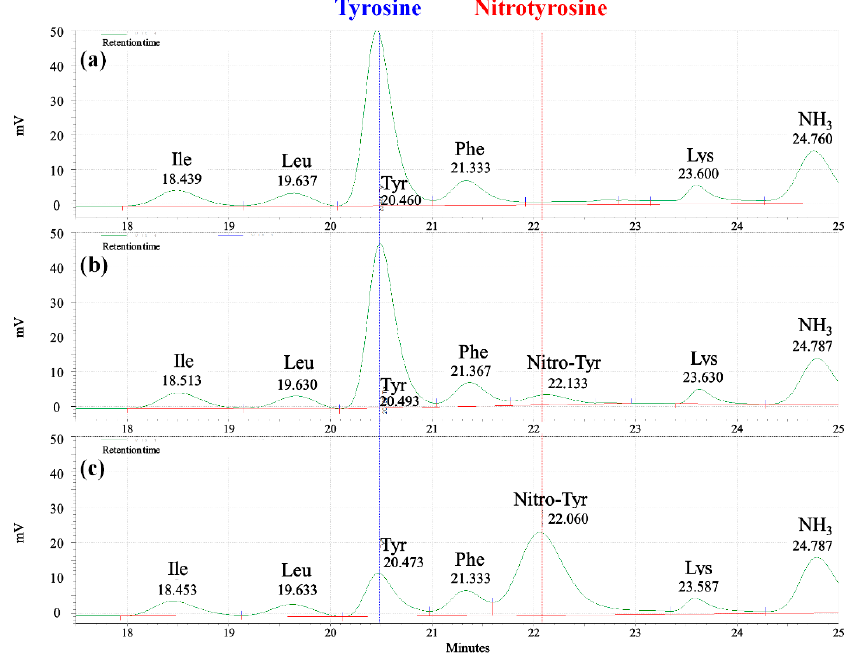
3 concentration.